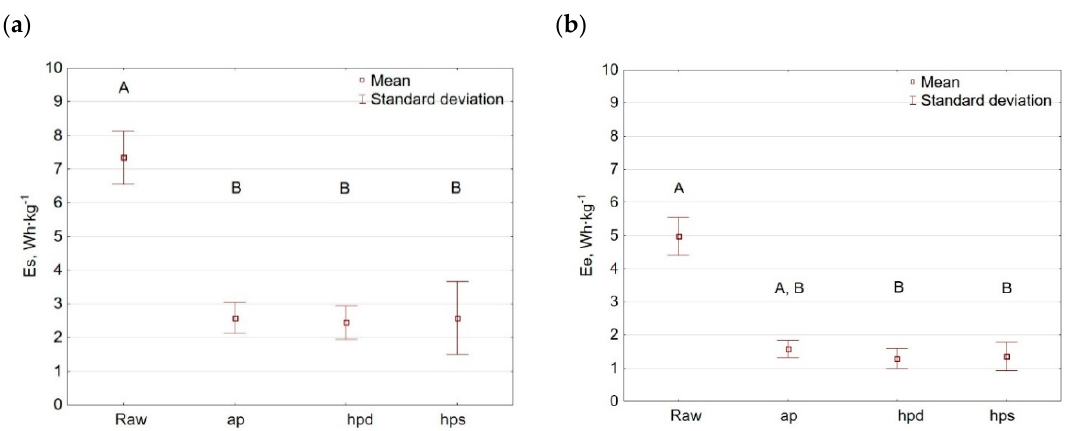
Figure 17. The results of the post-hoc HSD Tukey’s test for the grinding test, ( a ) total specific energy ( Es ), ( b ) specific effective energy ( Ee ).